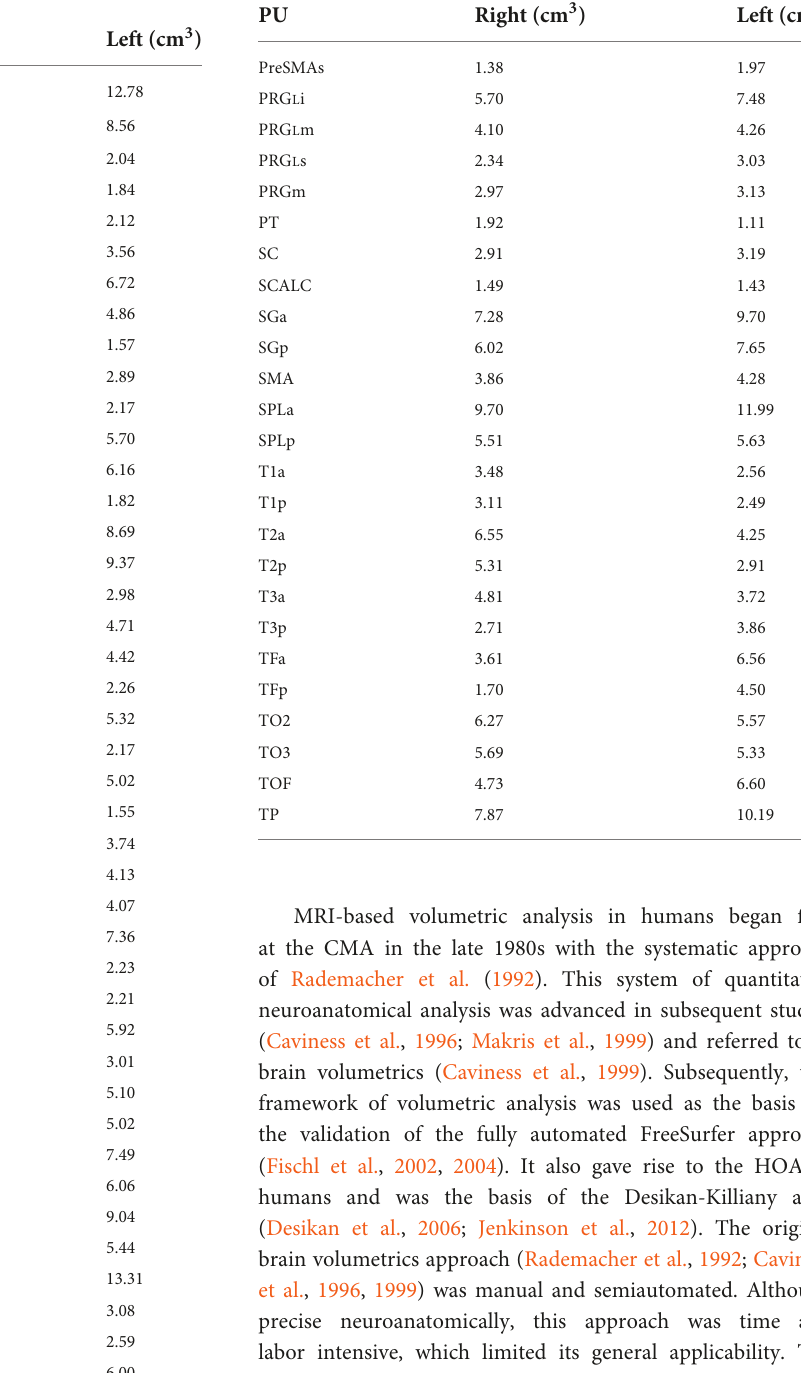
TABLE 5 Human Harvard-Oxford Atlas (hHOA) parcellation unit volumes from single